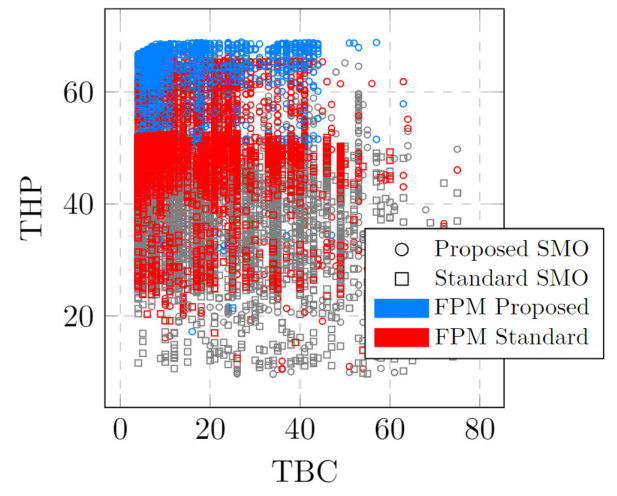
Figure 11. Rules quality comparison for the 7 machines